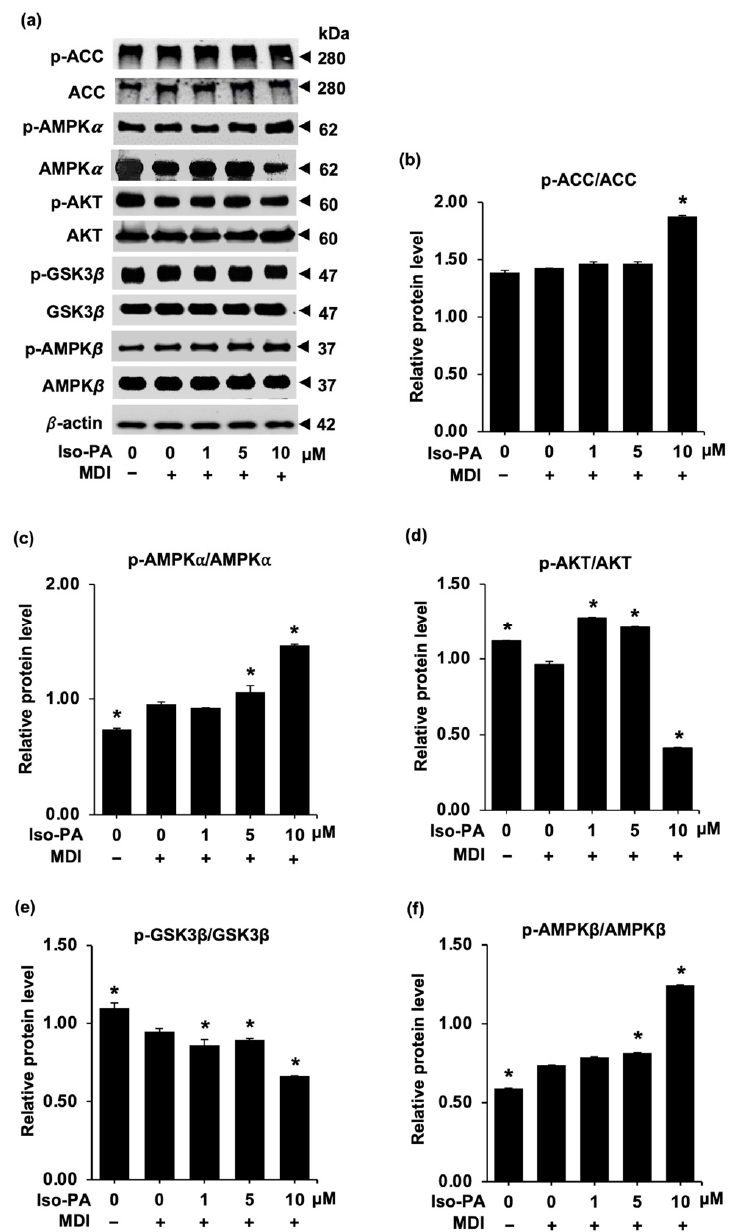
Figure 7. Regulatory effects of isopanduratin A on AKT-related signaling pathways. Isopanduratin